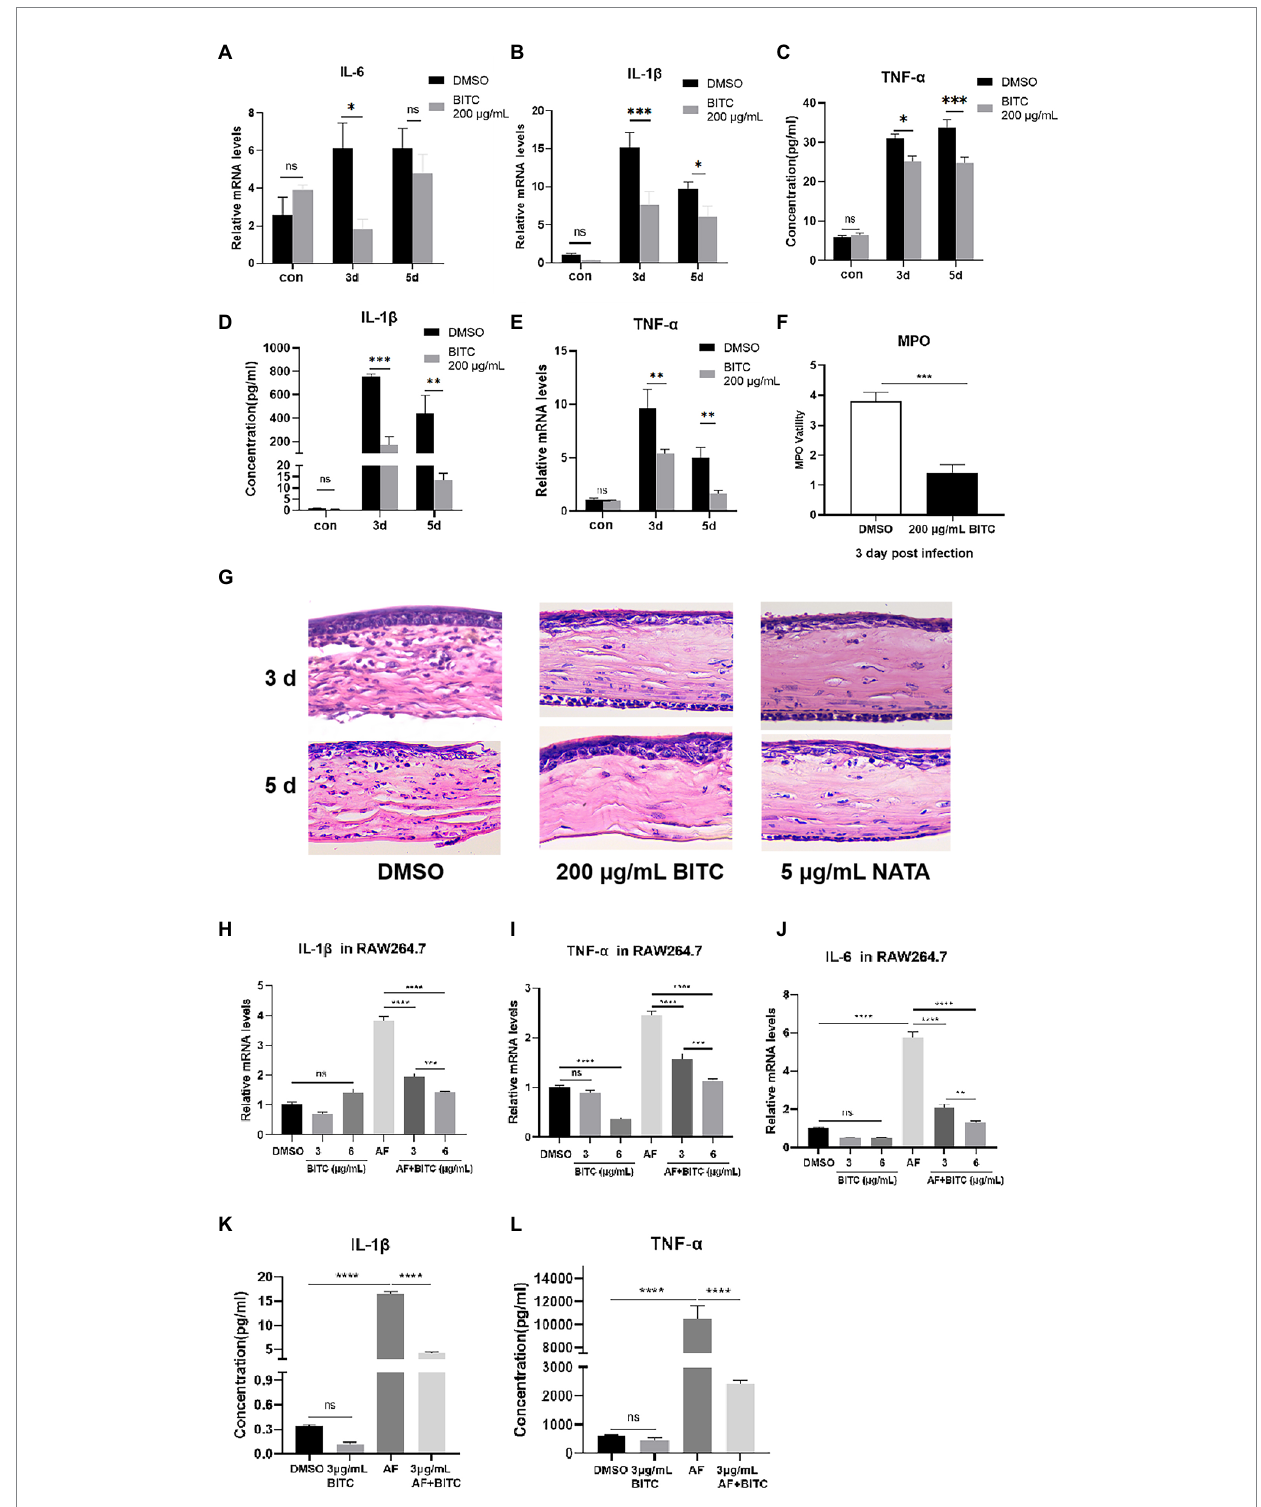
FIGURE 6 BITC inhibits inflammatory response in vivo and in vitro . RT-PCR results for IL-6 (A) , IL-1 β (B) , TNF- α (C) and ELISA results for IL-1 β (D) , TNF- α (E) at 3, 5 days p.i. in normal and A. fumigatus -infected mice cornea under BITC (200 μ g/ml) or 0.1% DMSO treatment. Levels of MPO (F) in A. fumigatus cornea under BITC (200 μ g/ml) or 0.1% DMSO treatment. HE staining (G) of infected corneas under 0.1% DMSO, BITC (200 μ g/ml) or NATA (5 μ g/ml) treatment at 3 days p.i. (magnification ×400). The mRNA levels of IL-1 β (H) , TNF- α (I) , and IL-6 (J) at 8 h and protein levels of IL-1 β (K) and TNF- α (L) at 24 h in RAW264.7 cells infected by A. fumigatus . Values represent as means ± SD (* p < 0.05, ** p < 0.01, *** p < 0.001, **** p <